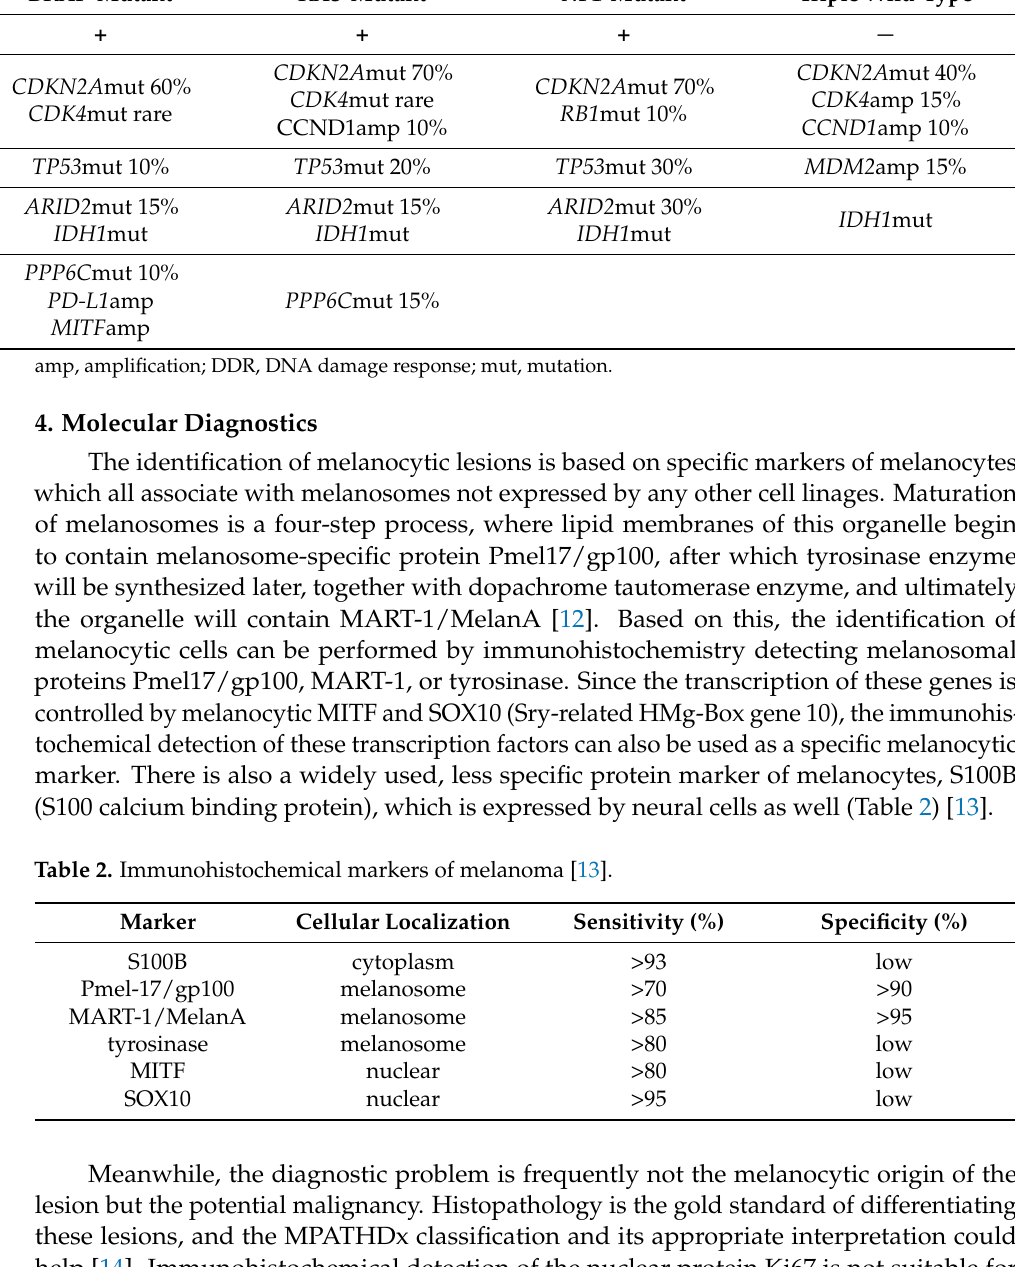
Table 1. Molecular subtypes of melanoma [8]. BRAF -Mutant RAS -Mutant NF1 -Mutant Triple Wild-Type